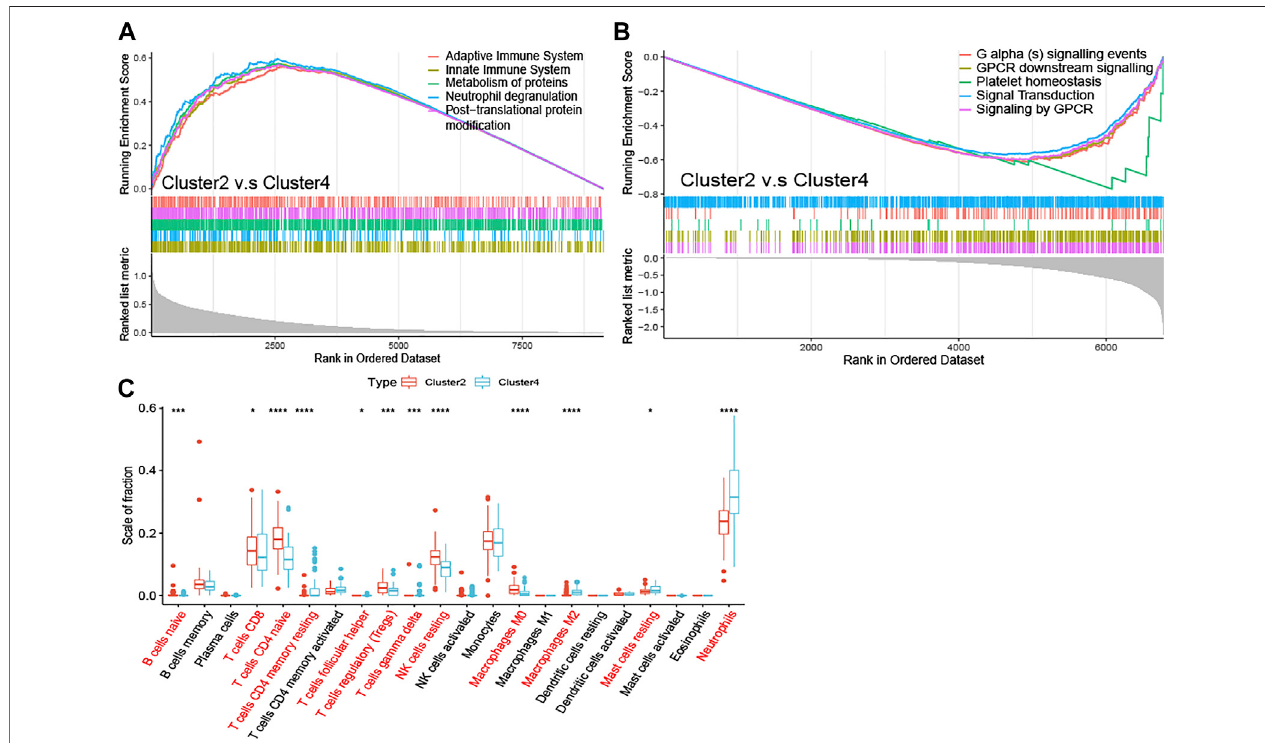
FIGURE 4 | Enrichment analysis and peripheral immune in fi ltration characteristics of NAD+ metabolic subtypes with distinct prognosis (A) GSEA for Cluster2 and Cluster4.Immunepathwaysandproteinmetabolicpathwaysweresigni fi cantlyenrichedinCluster2 (B) andGPCRsignaling-relatedpathwaysweresigni fi cantlyenriched in Cluster4 (C) Boxplots showed immune cell in fi ltration differences between Cluster2 and Cluster4. * p < 0.05; ** p < 0.01; *** p < 0.001, and **** p < 0.0001.